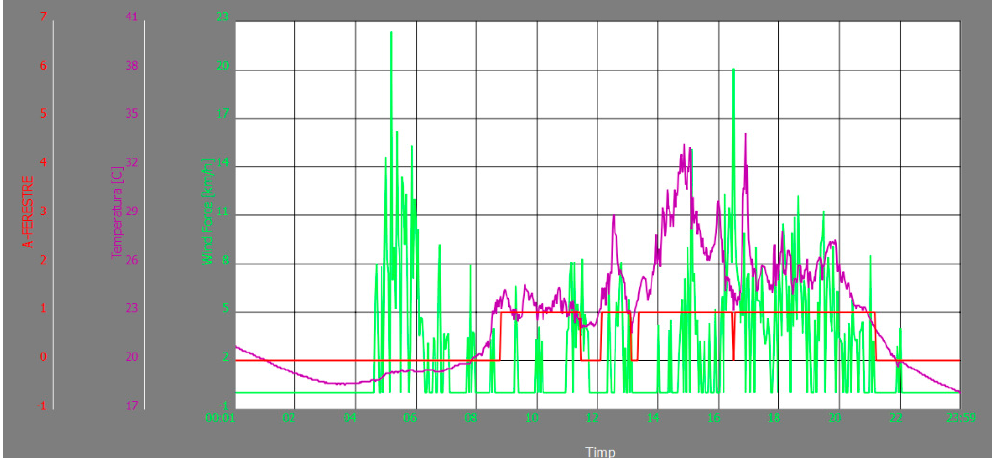
Figure 27. Environmental parameter dynamics monitored in the fourth day of water stress induction.